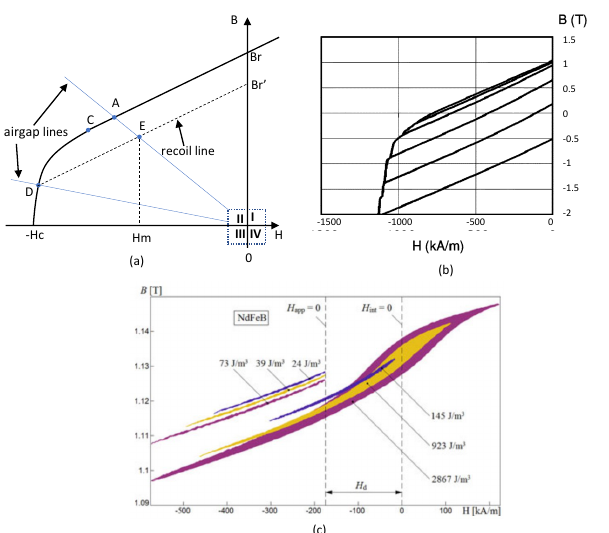
Figure 1. ( a ) Theoretical BH curve of a PM; ( b ) measured recoil curves of a NdFeB sample at 120 ◦ C [3]; ( c ) measured minor hysteresis loops in a magnet at room temperature